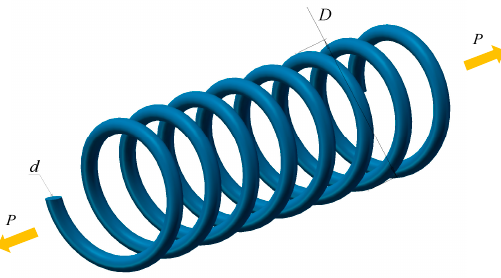
Figure 11. Model of tension/compression spring design.